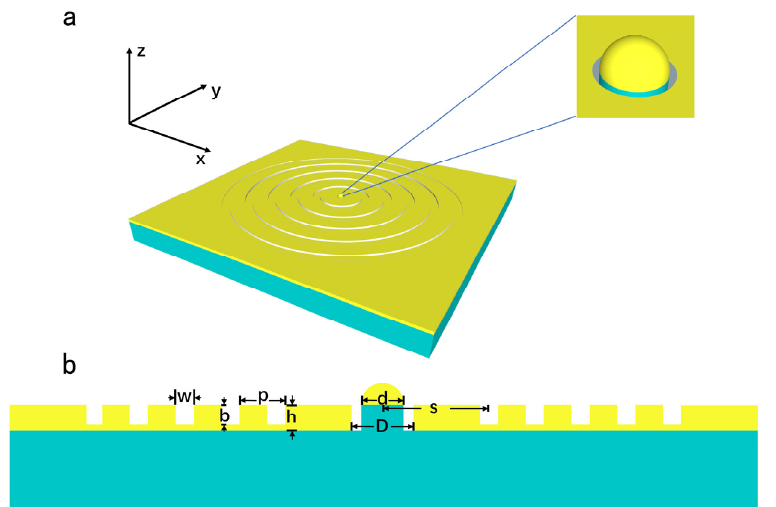
Figure 1. Schematic representation of the HIHB structure under study. ( a ) A three-dimensional schematic of the HIHB structure with an enlarged view of 3D hemispherical structure shown above; ( b ) cross profile shows the relevant parameters of the designed structure; b , w , s and p are the groove depth, the groove width, the distance from the aperture center to the first groove and the groove period, respectively. The hole diameter D = 18 µm, the film thickness h = 5 µm, and the hemisphere diameter is 15 µm.